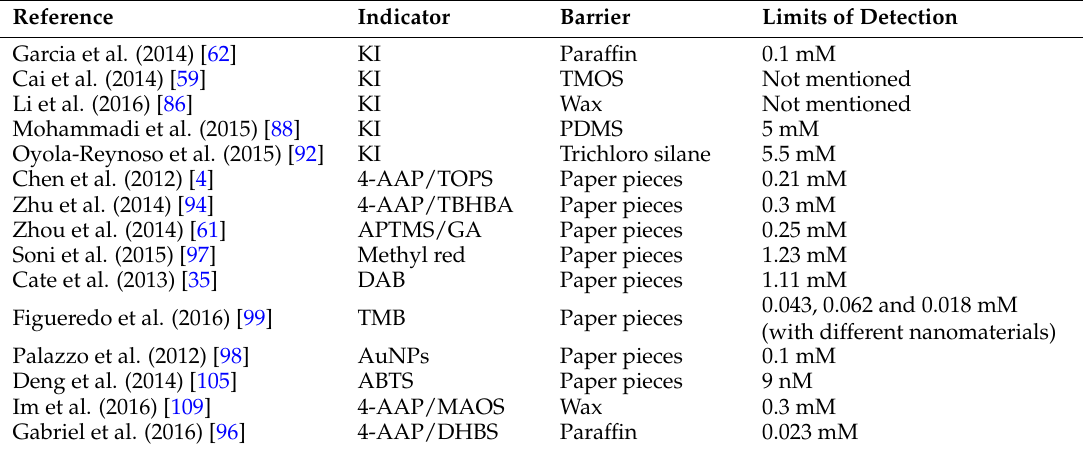
Table 1. Summary of the colorimetric μ PADs for glucose detection in representative references. TMB: